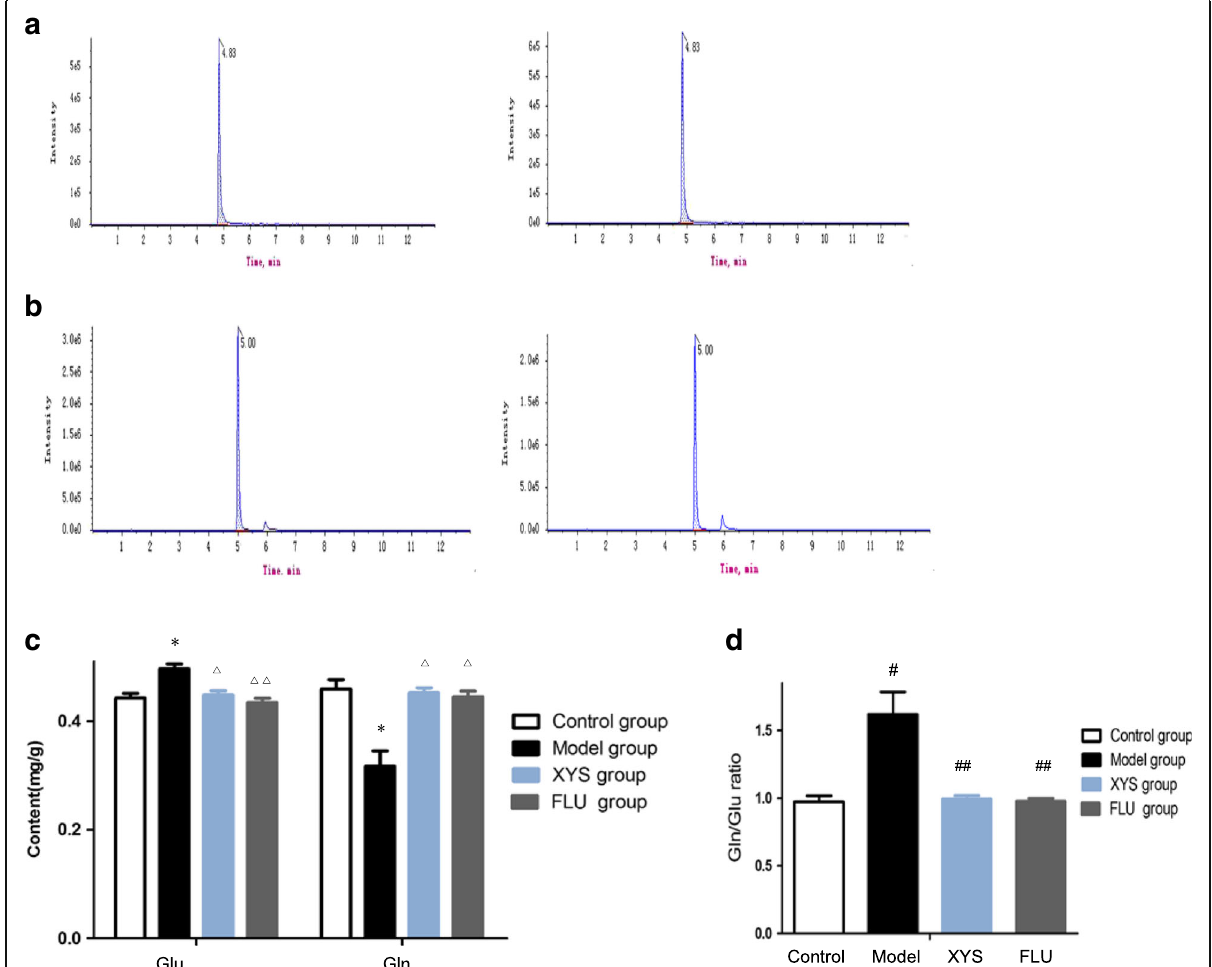
Fig. 4 Alterations of contents of Glu and Gln, and the Gln/Glu ratio in the hippocampi of mice by CUMS as well as XYS and FLU treatment. a Chromatograms of Glu. b Chromatograms of Gln. Results on references are shown on the left side, and results on hippocampal samples are shown on the right side. c The contents of Glu and Gln in the hippocampi were detected by LC-MS/MS. d The glutamate/glutamine ratio was calculated. Data were expressed as mean ± S.E.M, n = 5 per group. ∗ P < 0.05, △△ P < 0.01, # P < 0.001 vs. control; △ P < 0.05, ## P < 0.001 vs.